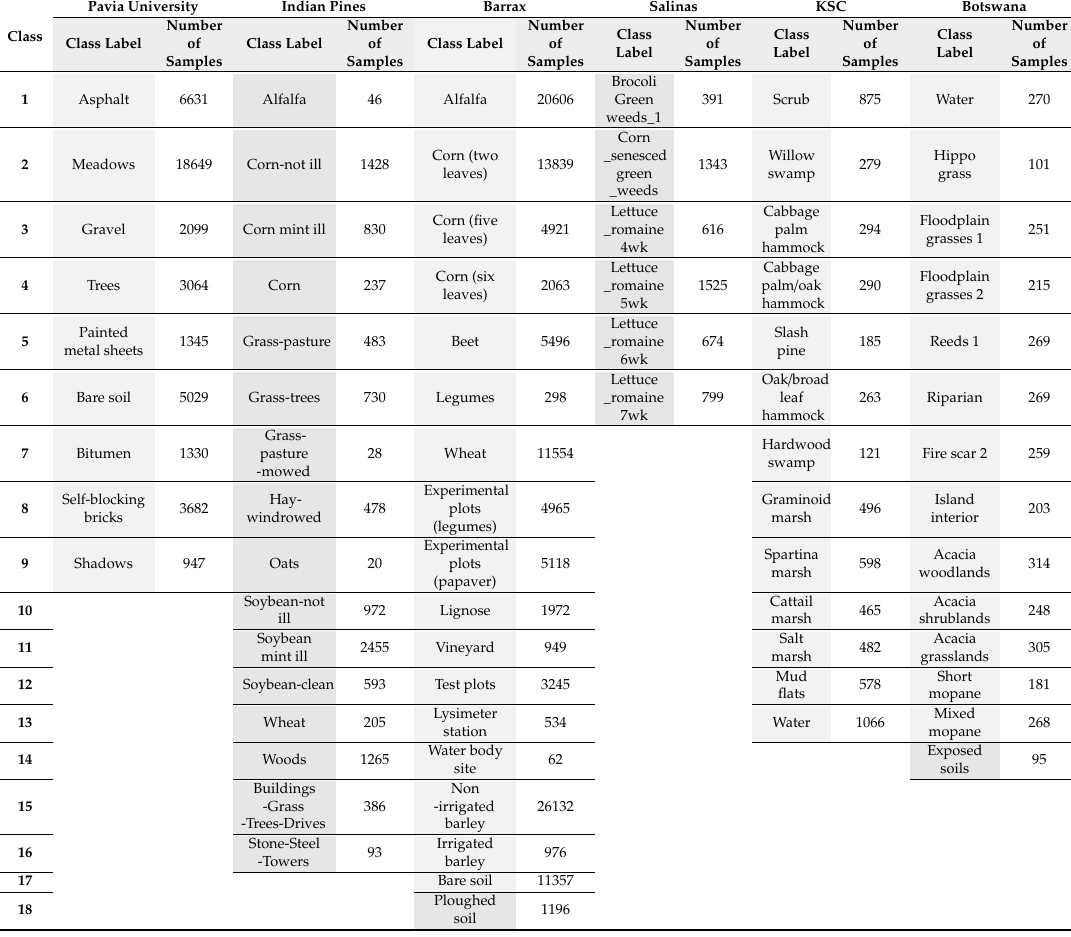
Table 2. Tabulates the class sizes and the nature of the class for all six datasets that have been utilized in this study. It is to note that the class sizes of the Botswana dataset are relatively uniform with an average size of 237 pixels over all classes in this data